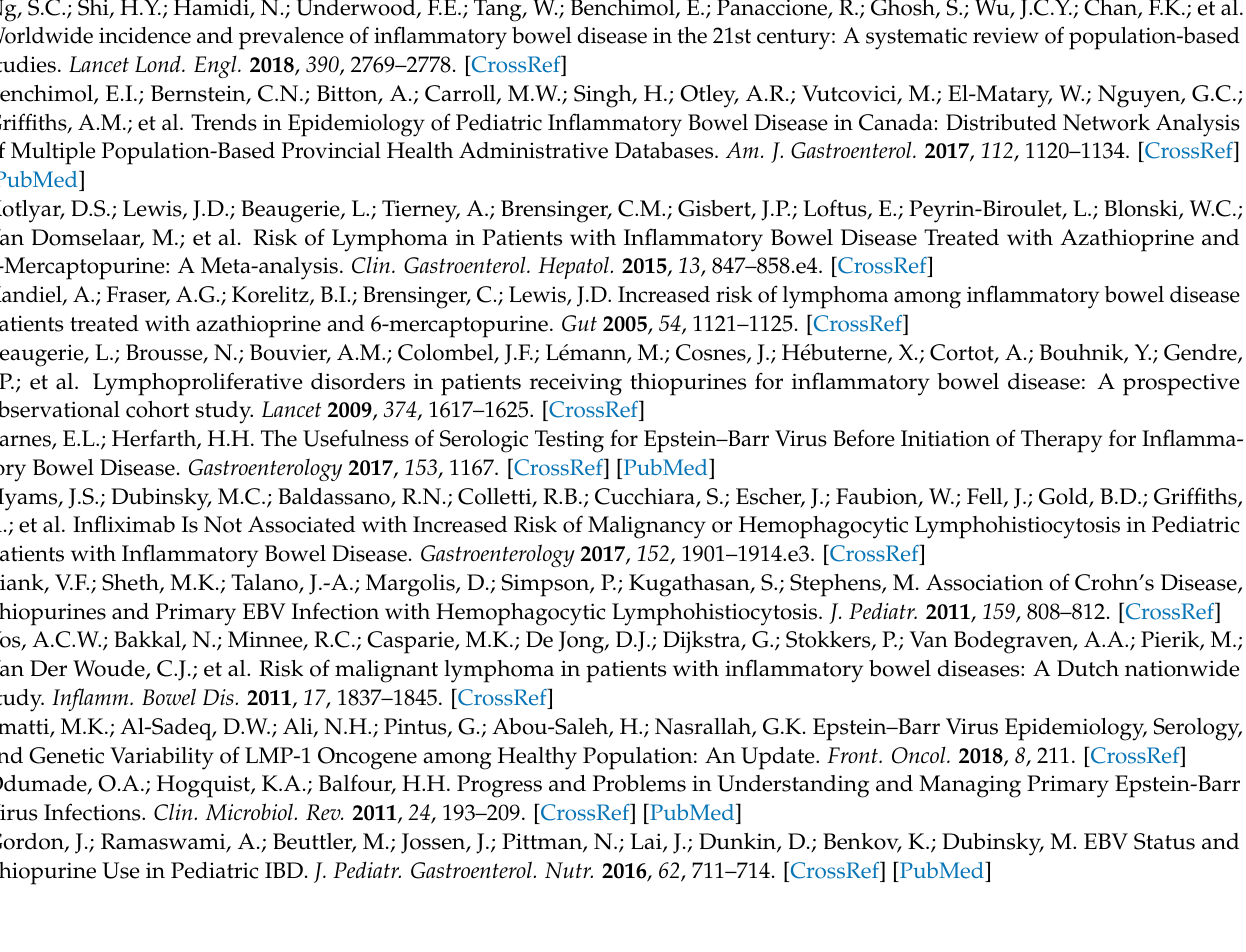
Characteristics of patients with available follow up Epstein-Barr virus (EBV) serology ( N = 66). Results are represented in mean and standard deviation (SD) or median and interquartile range (IQR). Figure S1: Flow chart of study population. Figure S2: Box plot for age at first inflammatory bowel disease (IBD) diagnosis by Epstein-Barr virus (EBV) status ( N = 194), p =